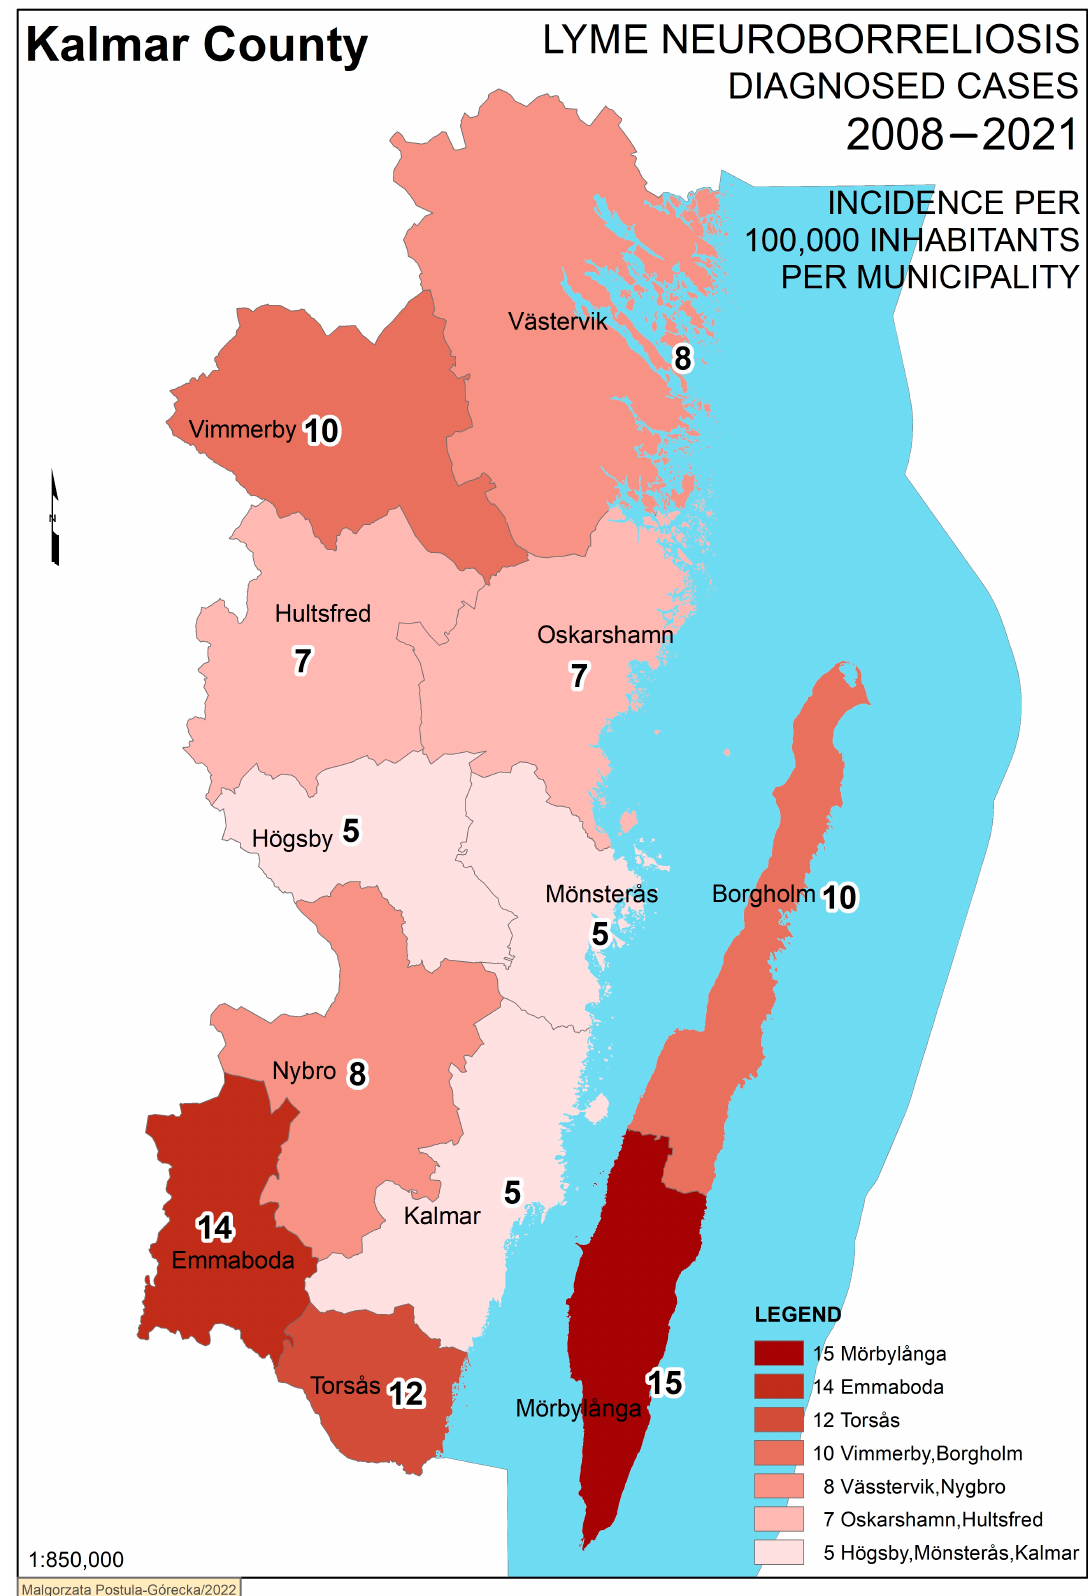
Figure 5. Mean annual incidence in each